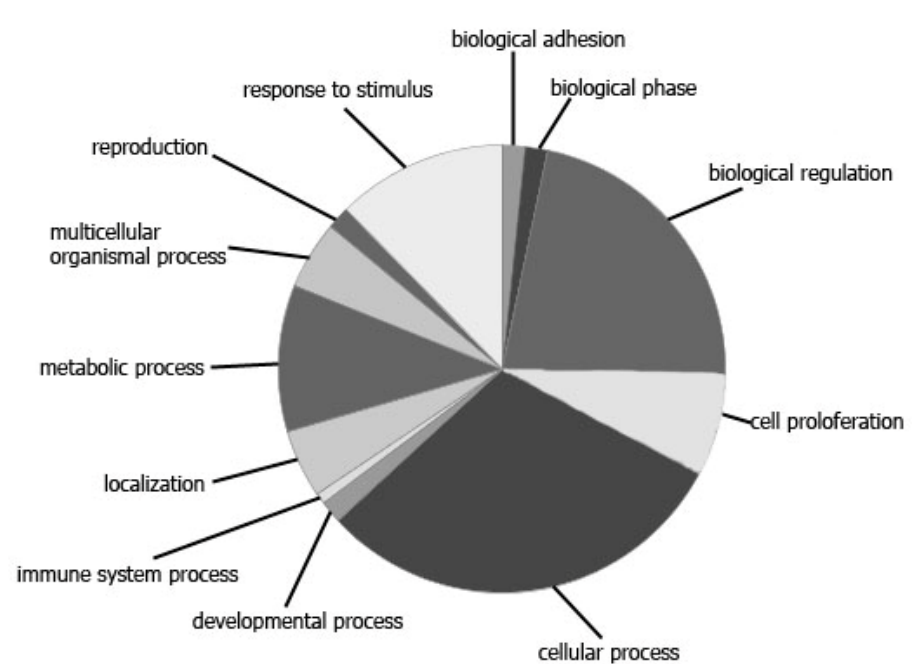
Figure 4. Target genes for miR-660, miR-30 е , miR-125b, miR-205, miR-375, miR-378, miR-19b and miR-425, which are involved in prostate cancerogenesis. PANTHER data: GO-Slim Biologic Process.